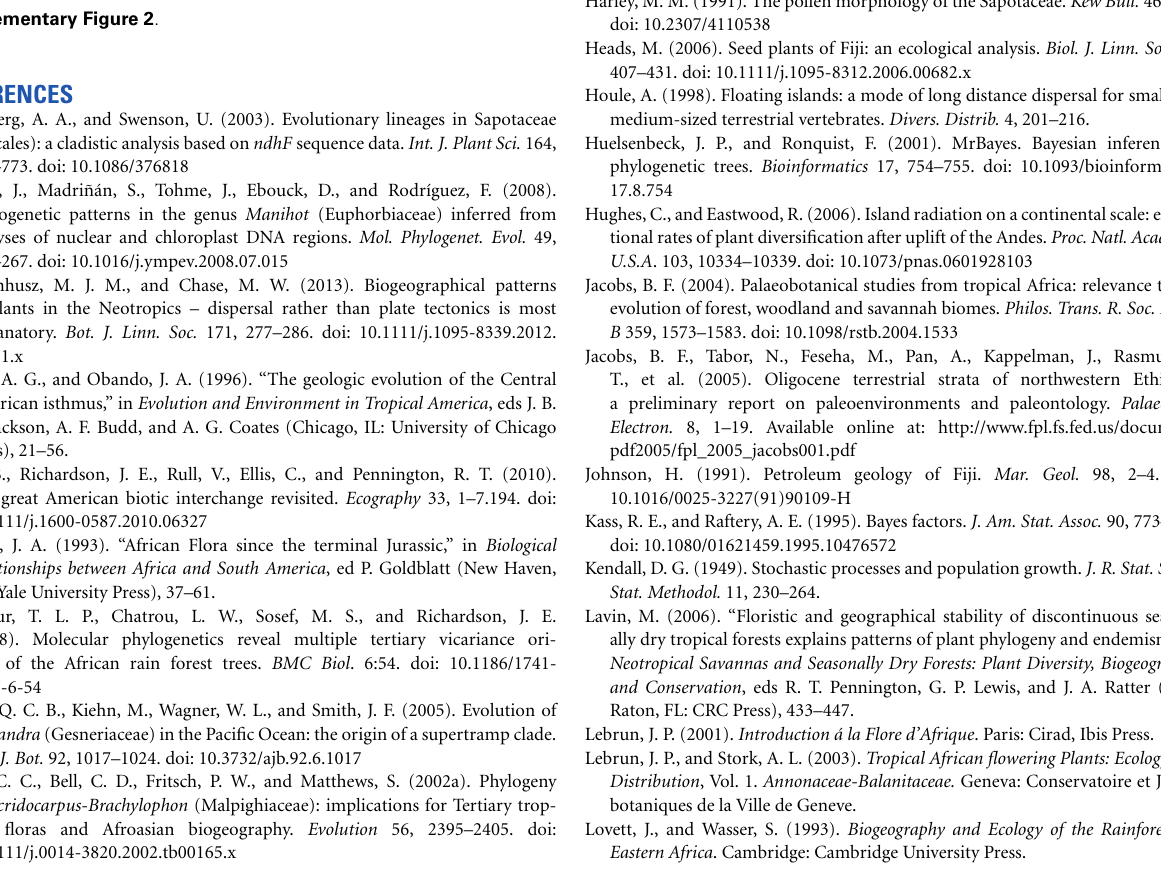
Supplementary Figure 1 | Bayesian majority rule consensus tree of the chloroplast dataset. Posterior probability values are indicated above branches. Nodes with letters/symbols are discussed in the text. Supplementary Figure 2 | Phylogenetic tree used in the BAMM analysis showing the nodes for which a proportion of sampled species was calculated, as shown in Supplementary Table 3. Supplementary Table 1 | Herbarium specimen data, GenBank accession number and ancestral area coding for taxa included in the analyses. Accessions of newly generated sequences are emboldened. Supplementary Table 2 | Chloroplast primers designed for this study. Supplementary Table 3 | Lineage specific correction used to take into account incomplete taxon sampling in the BAMM analysis. The unsampled species were assigned to the more recent node including the species with the most similar morphology. The proportion of sampled over total taxa was calculated for the nodes shown in Supplementary Figure 2